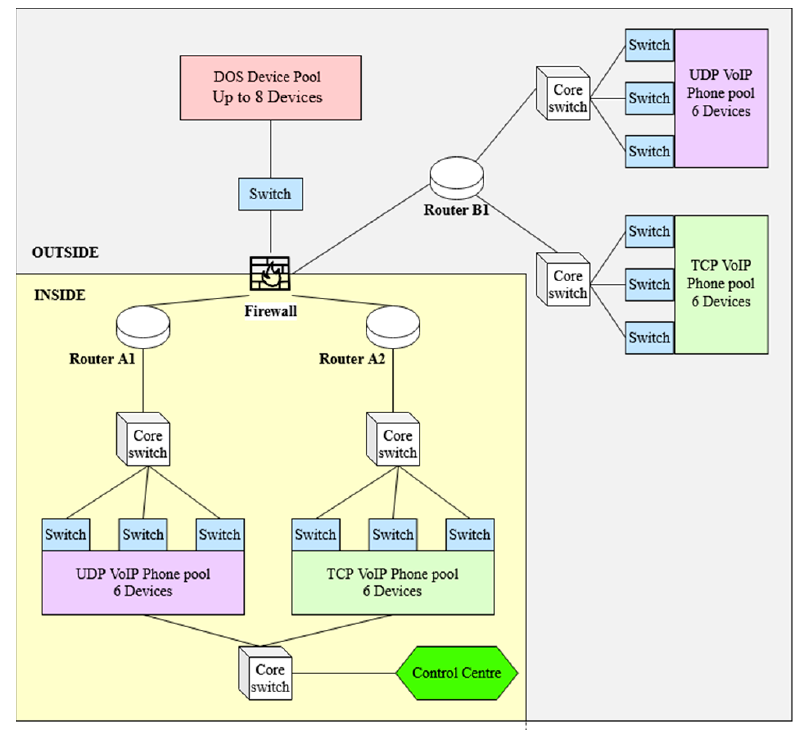
Figure 5. Topology of the Cisco Packet Tracer network.